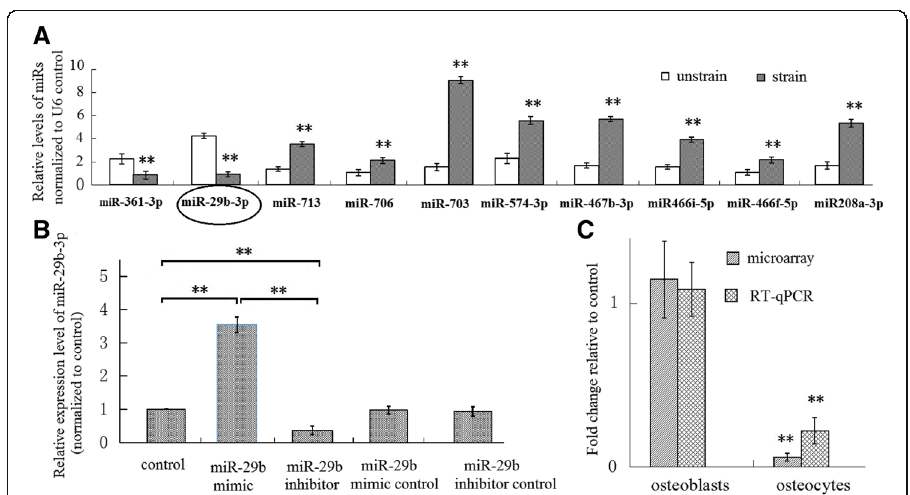
Fig. 3 In MLO-Y4 osteocytes, miR-29b-3p was one of the ten mechanoresponsive miRs which were confirmed by RT-qPCR. a Based on microarray assay of miRs, the result of RT-qPCR showed that ten miRs were responsive to the mechanical tensile strain, and miR-29b-3p was one of the ten miRs ( n =5). b The miR-29b-3p mimic elevated miR-29b-3p level of osteocyte and the miR -29b-3p inhibitor decreased the miR level ( n = 5). c In MC3T3-E1 osteoblastic cells, the mechanical tensile strain did not change the expression of miR-29b-3p, which was demonstrated with microarray and RT-qPCR. Contrarily, in MLO-Y4 osteocytes, the mechanical strain decreased miR-29b-3p expression ( n =5). * P <0.05 and ** P <0.01, compared with the unstrained control